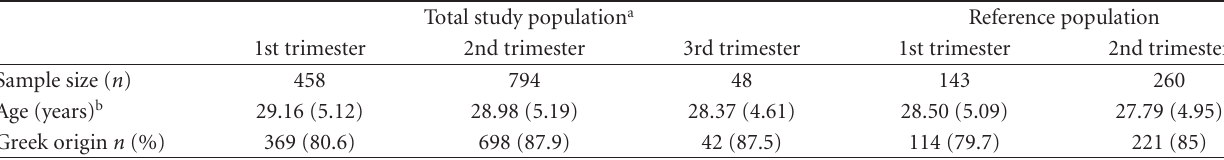
Figure 1: Flow diagram of the study process for the determination of the reference population. Table 1: Demographic data for pregnant women in total and reference study